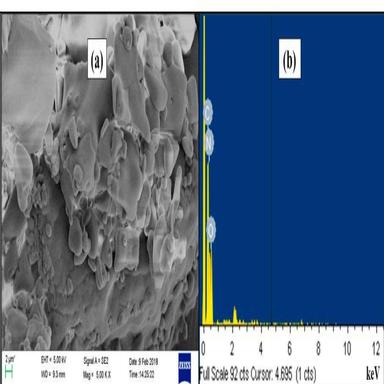
SEM/EDS analysis of GuHM.